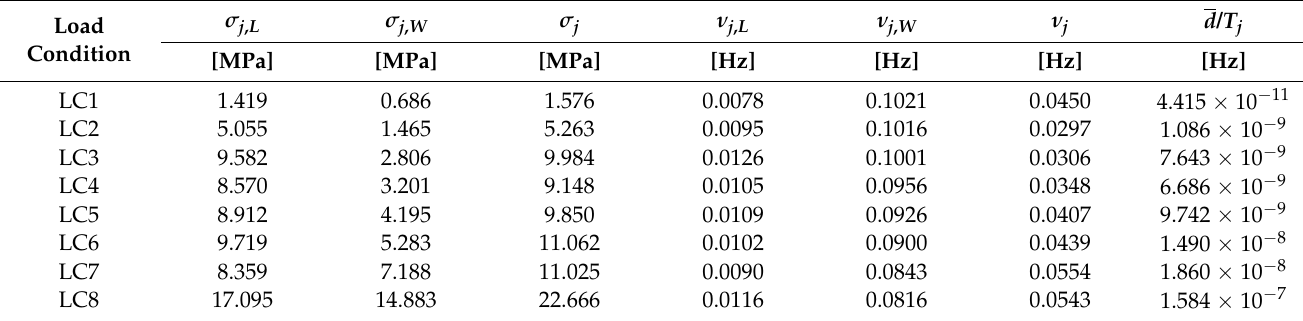
Figure 7. Spectra of the stress history in line #1. ( a ) Load condition LC1; ( b ) load condition LC2; ( c ) load condition LC3; ( d ) load condition LC4; ( e ) load condition LC5; ( f ) load condition LC6; ( g ) load condition LC7; ( h ) load condition LC8. Table 5. Fatigue assessment by spectral analysis—Welch